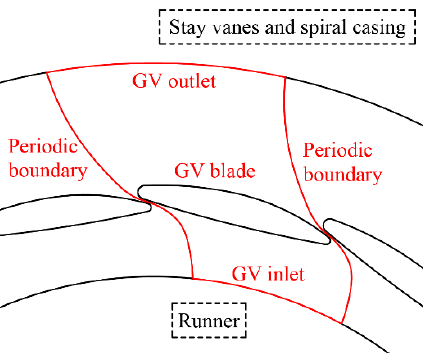
Figure 3. Two-dimensional computational domains for GV torsional self-excited vibration.